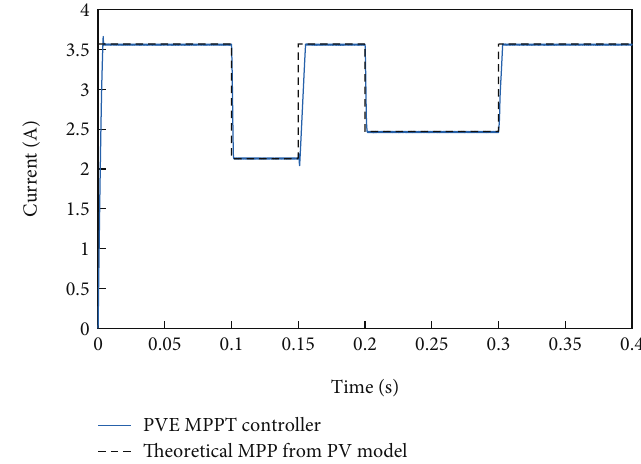
Figure 25: Current of the PVE system with MPPT control under fast-changing environmental conditions.